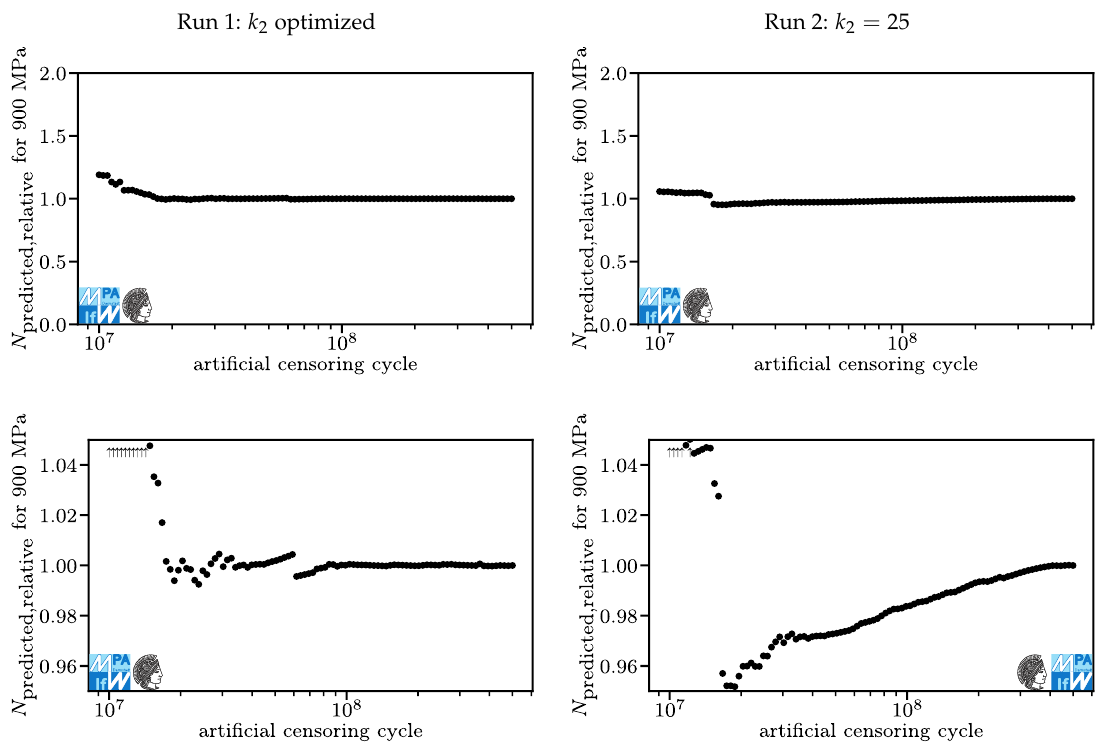
Figure 10. Lifetime predictions for Run 1 ( left ) and Run 2 ( right ), overview and detail for stroke stresses of 900